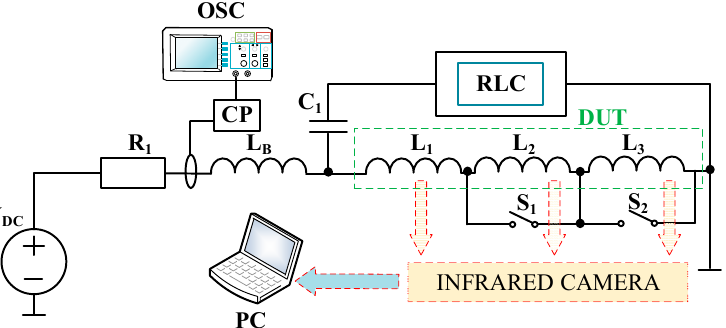
Figure 4. Setup for measuring the inductance of a coupled inductor using the LCR bridge.